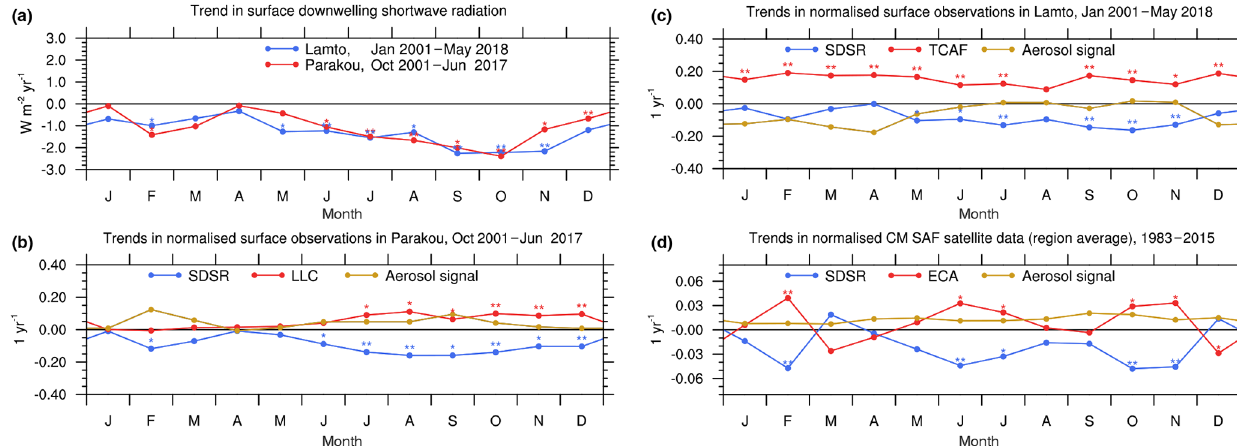
Figure 12. Trends in radiation. (a) Annual cycle of trends in surface downwelling shortwave radiation (SDSR) at Lamto and Parakou from 2001–2018 (see legends in panels for exact dates). (b–c) Normalized trends of SDSR and cloud cover at Parakou (b) and Lamto (c) . An aerosol signal (gold) is derived from SDSR and cloud cover (see Sect. 2.5 for details). While both stations measure SDSR, low and medium cloud cover (LLC) is only observed at Parakou. For Lamto the total cloud area fraction (TCAF; see Sect. 2.4) is used to calculate the aerosol signal. Panel (d) is the same as (b) and (c) but for CM SAF satellite data averaged over the entire study region (see Fig. 1). Instead of cloud cover the effective cloud albedo (ECA) is used to calculate the aerosol signal. In all panels a * (**) marks statistically significant trends on the α = 20% (5%)